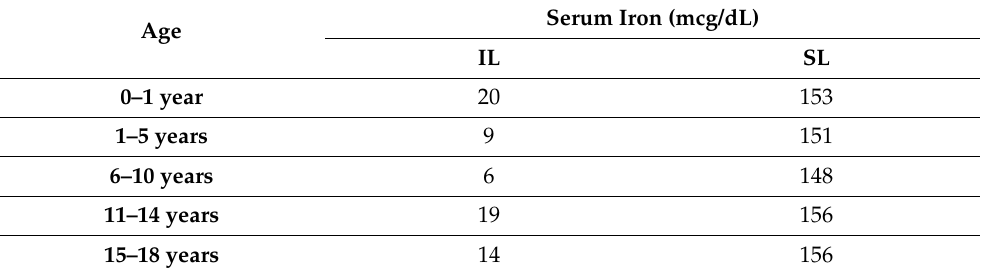
Table 4. Serum iron normal values for age groups